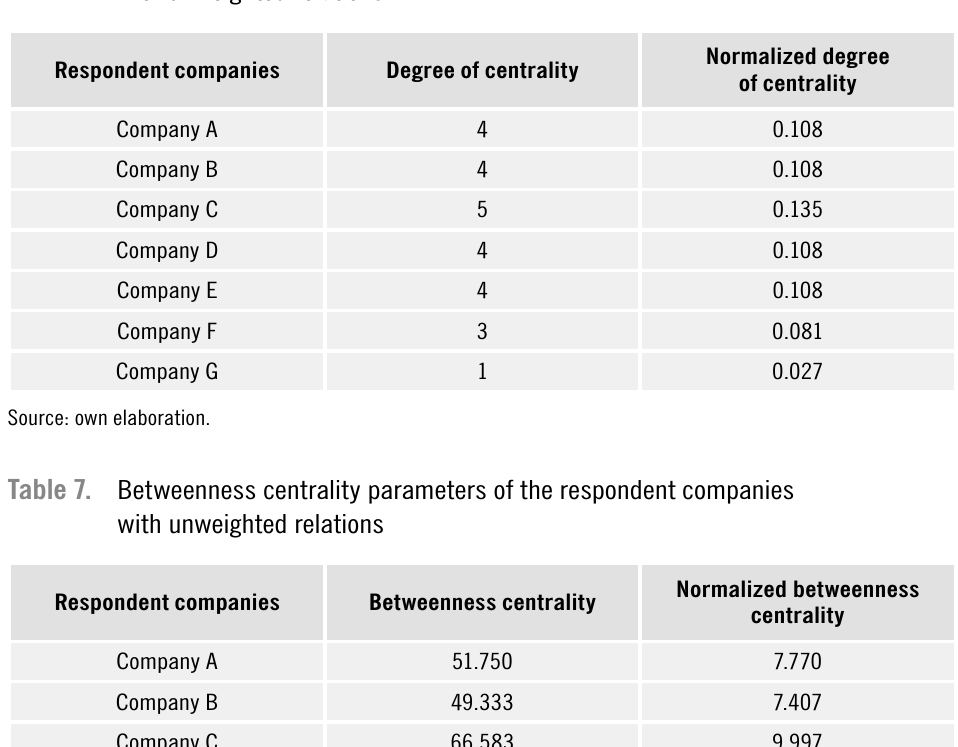
Table 6. Degree of centrality parameters of the respondent companies with unweighted relations